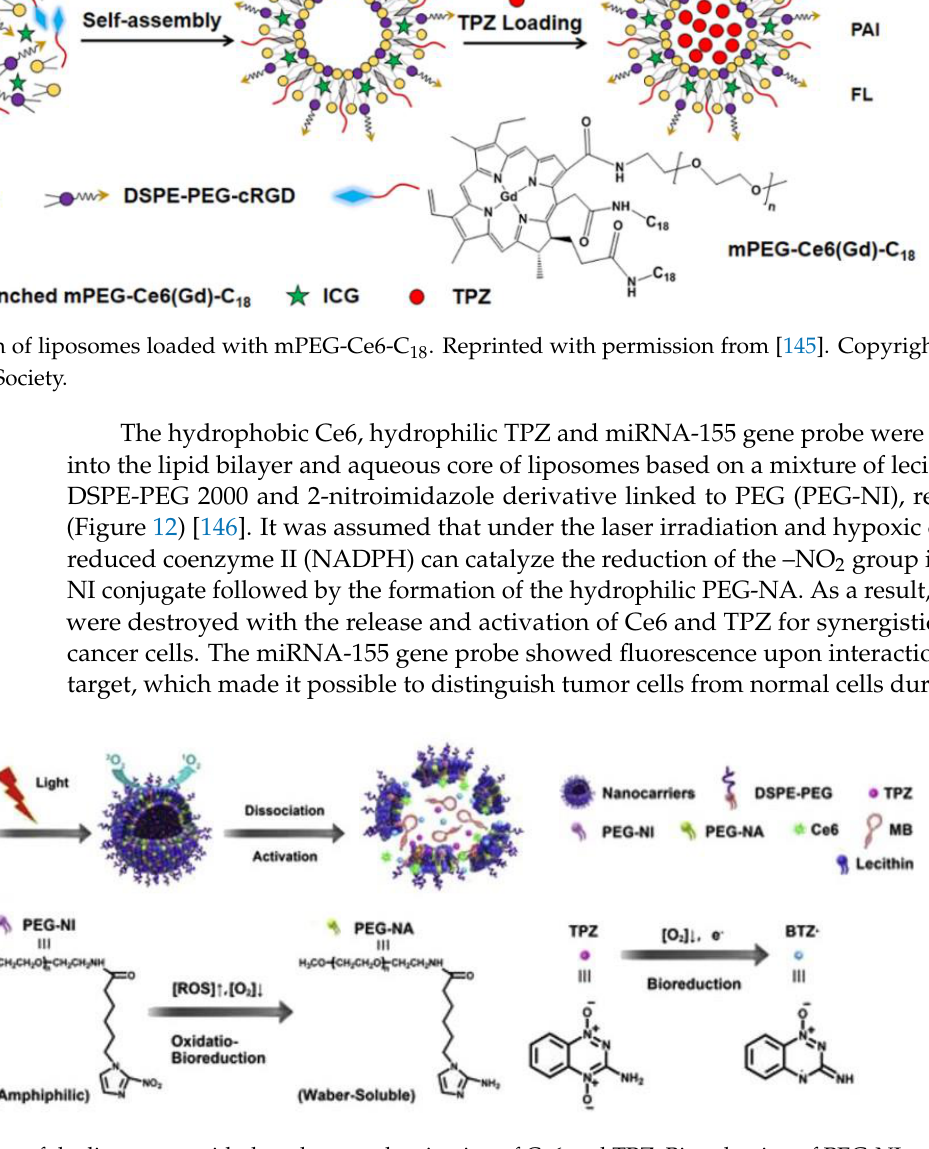
Figure 12. Dissociation of the liposomes with the release and activation of Ce6 and TPZ. Bioreduction of PEG-NI and TPZ. Reprinted with permission from [146]. Copyright 2018 Elsevier.